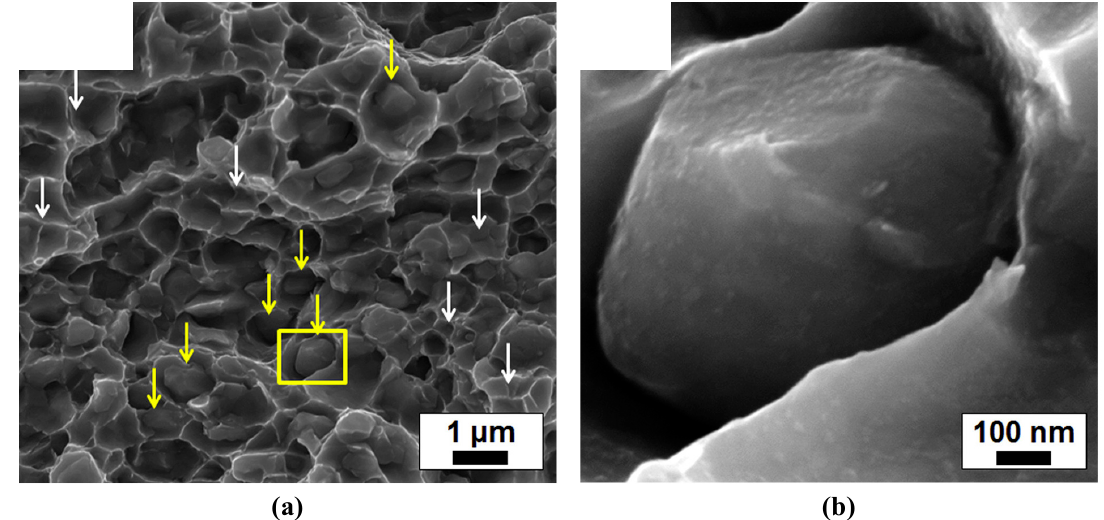
Figure 11. ( a ) SEM fractograph of H–charged medium–Mn steel specimen with an equiaxed ferrite–austenite microstructure. ( b ) Enlargement of the area indicated by a yellow box in ( a ). Reproduced from Reference [36], with permission from Elsevier.